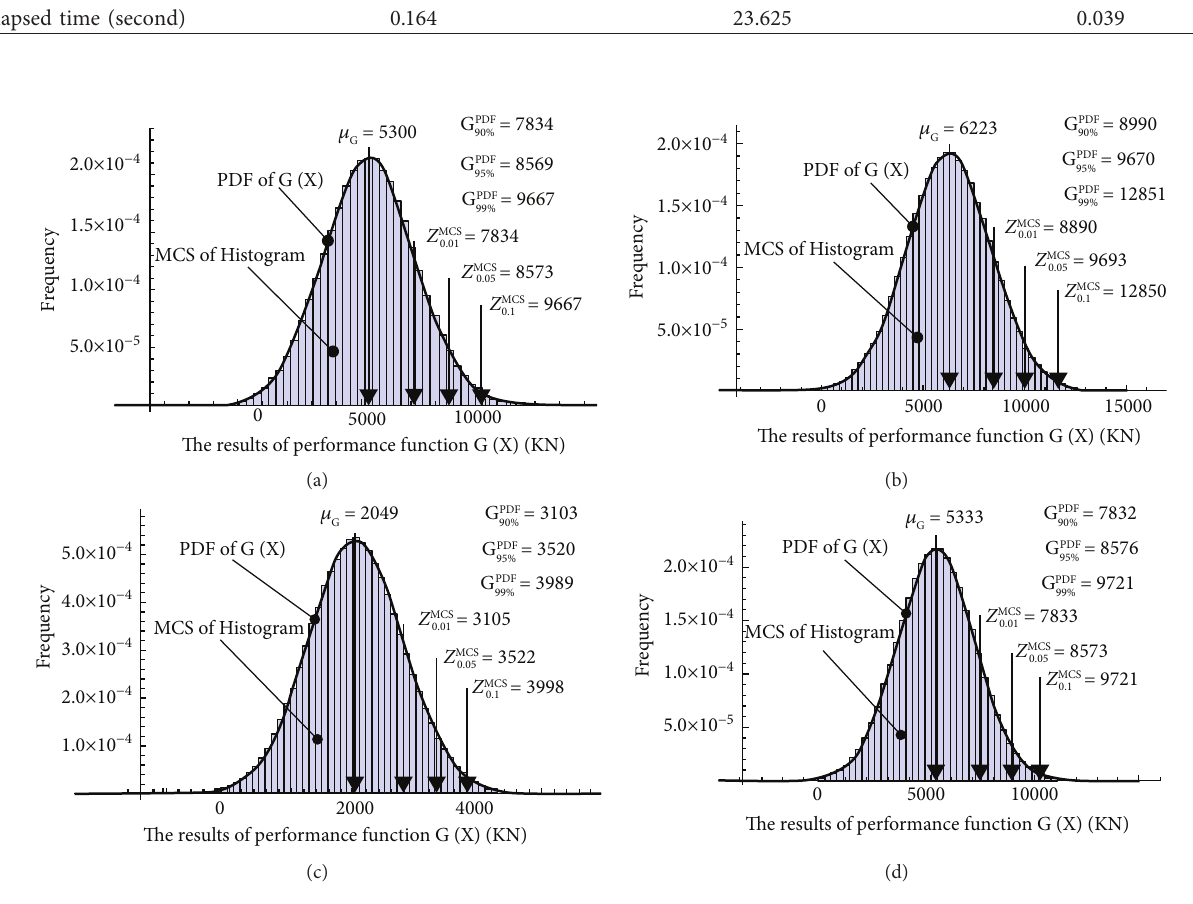
Figure 4: Histogram and PDF curve of a performance function for each pile foundation: (a) histogram and PDF curve for G ( X ) of no. 6, (b) histogram and PDF curve for G ( X ) of no. 9, (c) histogram and PDF curve for G ( X ) of no. 87, and (d) histogram and PDF curve for G ( X ) of no.